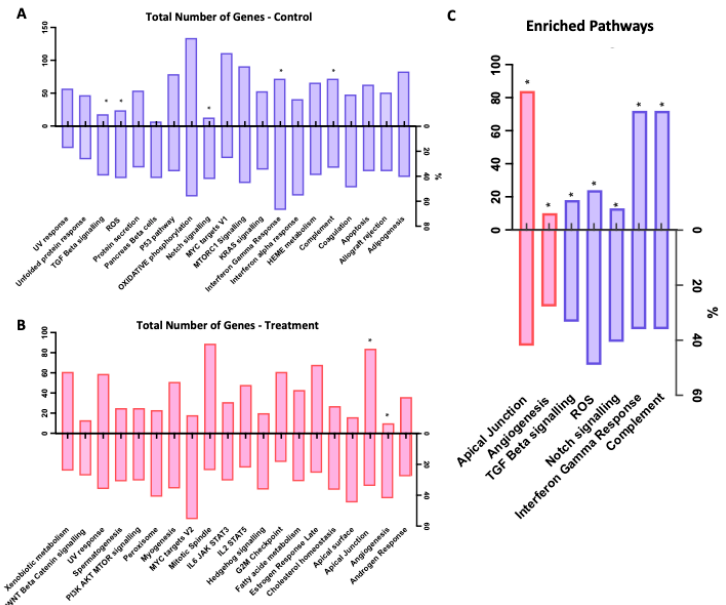
Figure 5. Selection of GSEA identified pathways influenced by asprosin in OvCa treated with 100 nM at 4 and 12 h combined. ( A ) Total pathways influenced by asprosin for control group (down regulated) in blue; ( B ) Total pathways influenced by asprosin for treatment group (up regulated) in red; ( C ) Combined pathways (regulation: up = red, down = blue) with pre-defined GSEA automated nominal p set to * p = 0.2.